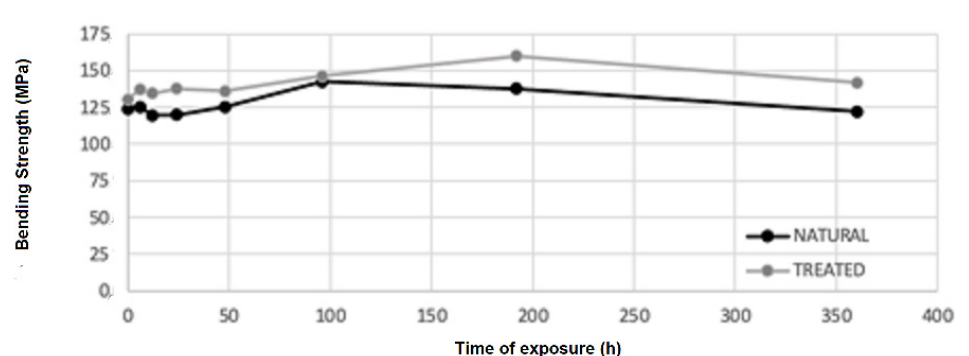
Figure 6. Bending test set-up. Change in bending strength according to different times of exposure for the average values of natural or treated samples.